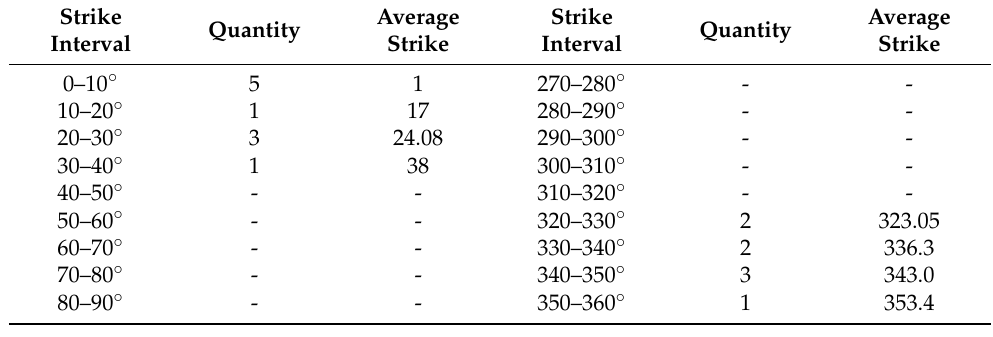
Figure 7. Ground fissure plane distributions. ( a , b ) top view of ground fissures; ( c ) distribution of ground fissures with an en echelon form; ( d – f ) ground fissure surface damage.